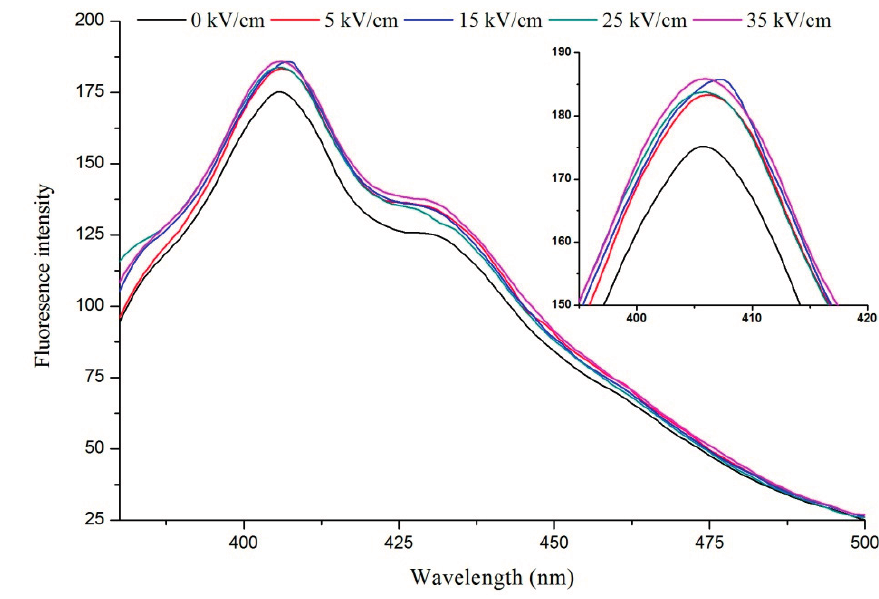
Figure 1. The effect of different electric field strength at 9 min on fluorescence of vitamin C